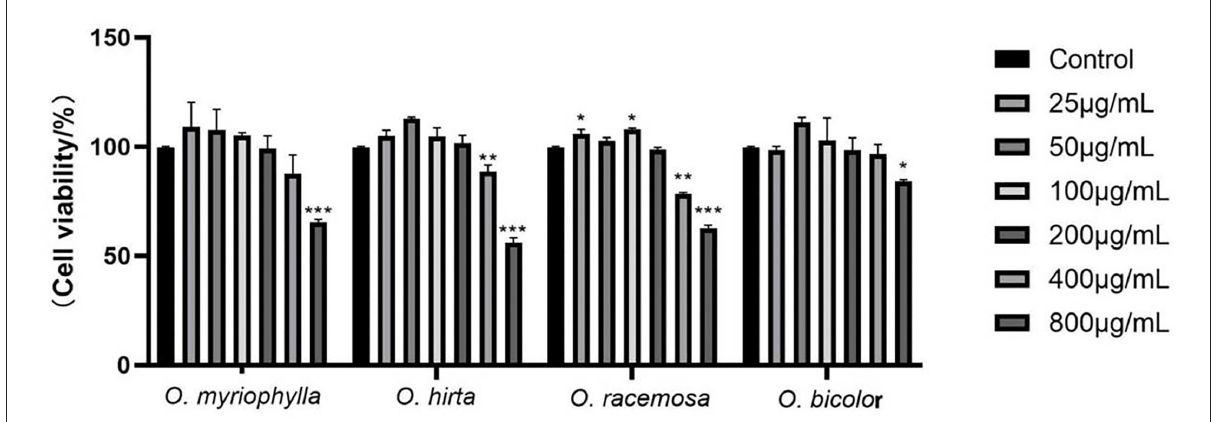
FIGURE7 Effects of the total extracts of the four Oxytropis on the proliferation of mouse RAW264.7 macrophages (Compared with the control group, * P < 0.05, ** P < 0.01, and *** P < 0.001).